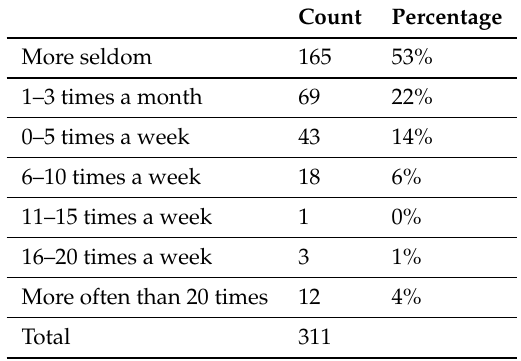
Table 6. The table shows how often the respondents of the questionnaire post on social media. The total here is missing about 18 people, due to an unexpected error with the